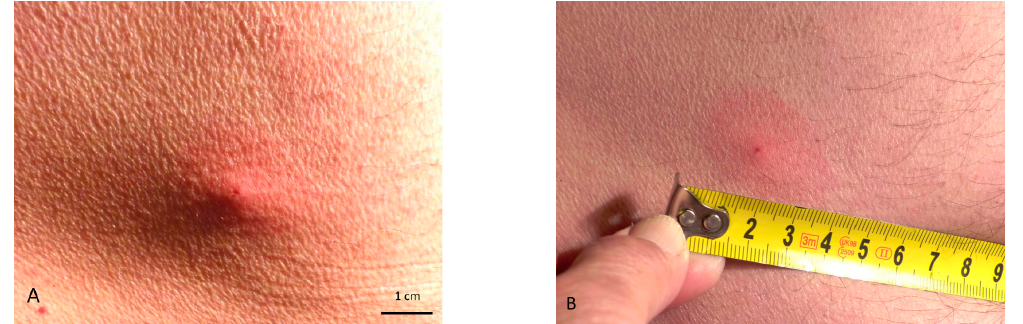
Figure 1. ( A ) A site of an Ixodes ricinus tick bite in the central part of the erythematous-infiltrative lesion, not sharply demarcated from the surrounding normal skin just after tick removal. ( B ) Lesion erythematous-infiltrative lesion with a diameter of 3 cm clearly demarcated from the surrounding normal skin. In the central part the infiltration decreased 48 h after tick removal.